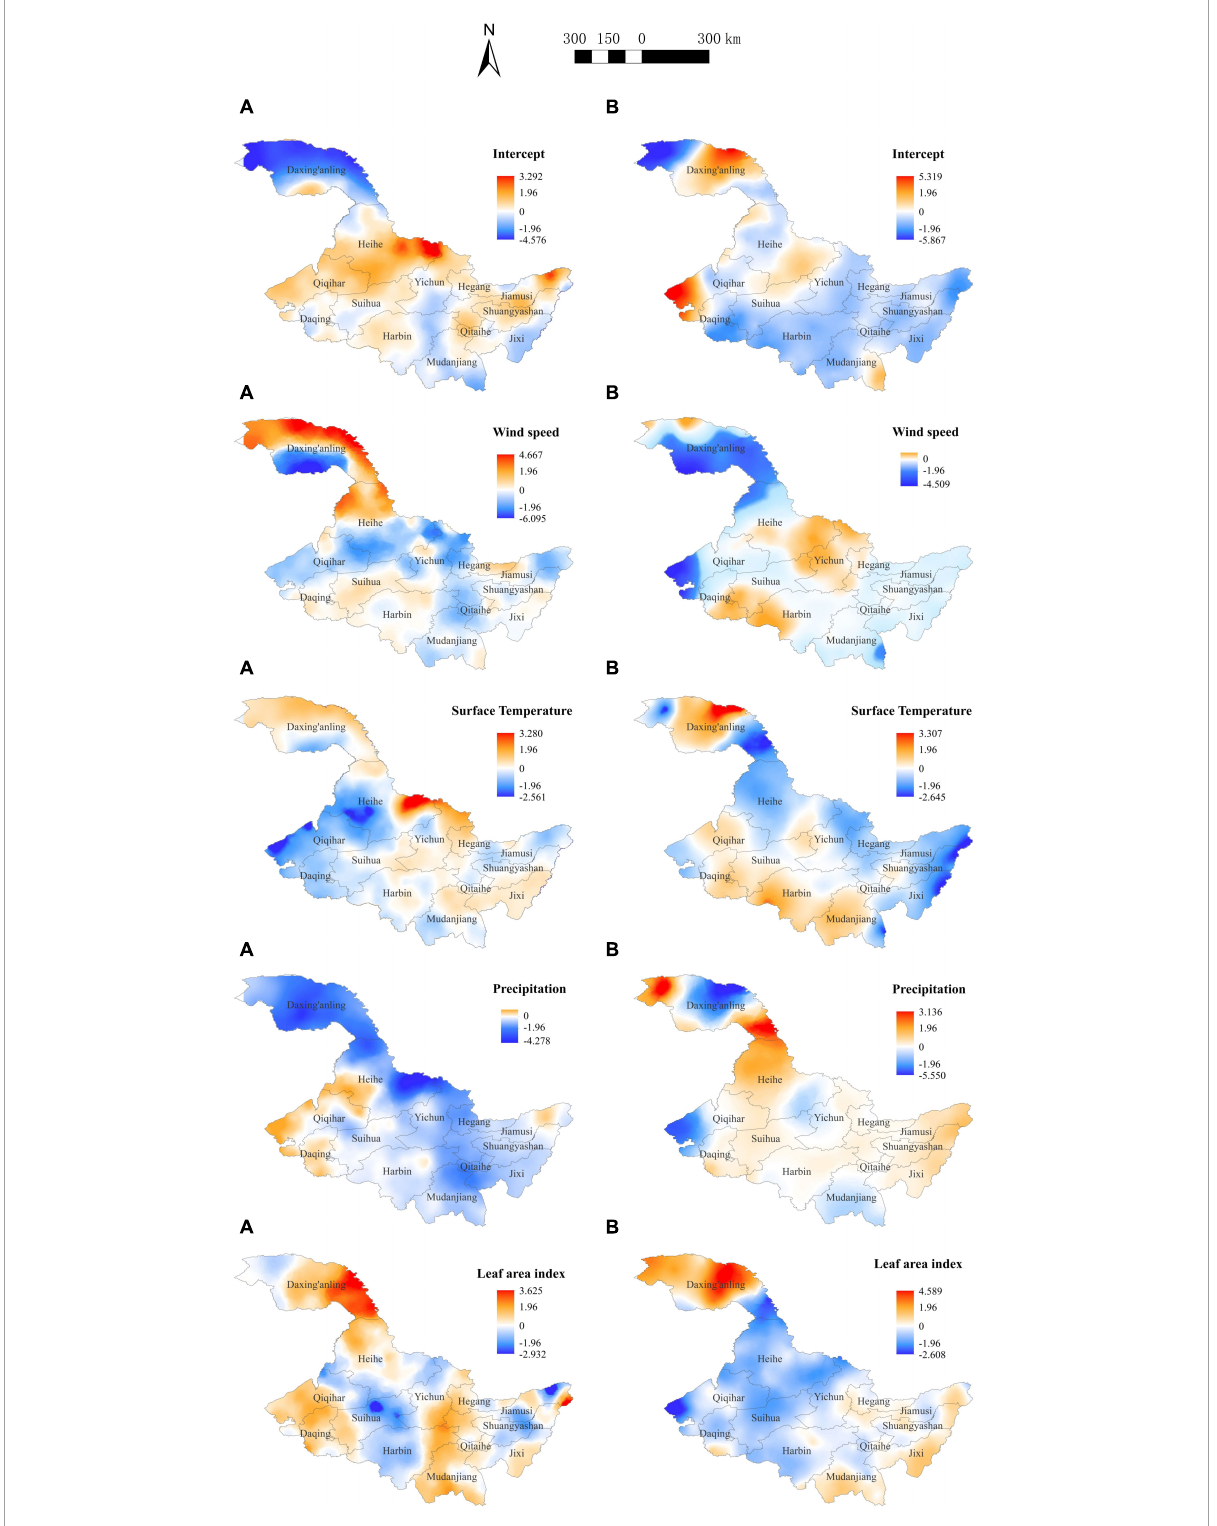
FIGURE4 Distribution of t -values for each parameter of the geographically weighted logistic regression (GWLR) model. (A) Distribution of t -values in spring fire prevention period. (B) Distribution of t -values in autumn fire prevention period. If the t -test value is less than –1.96 or greater than 1.96, it means that the estimated coefficient is